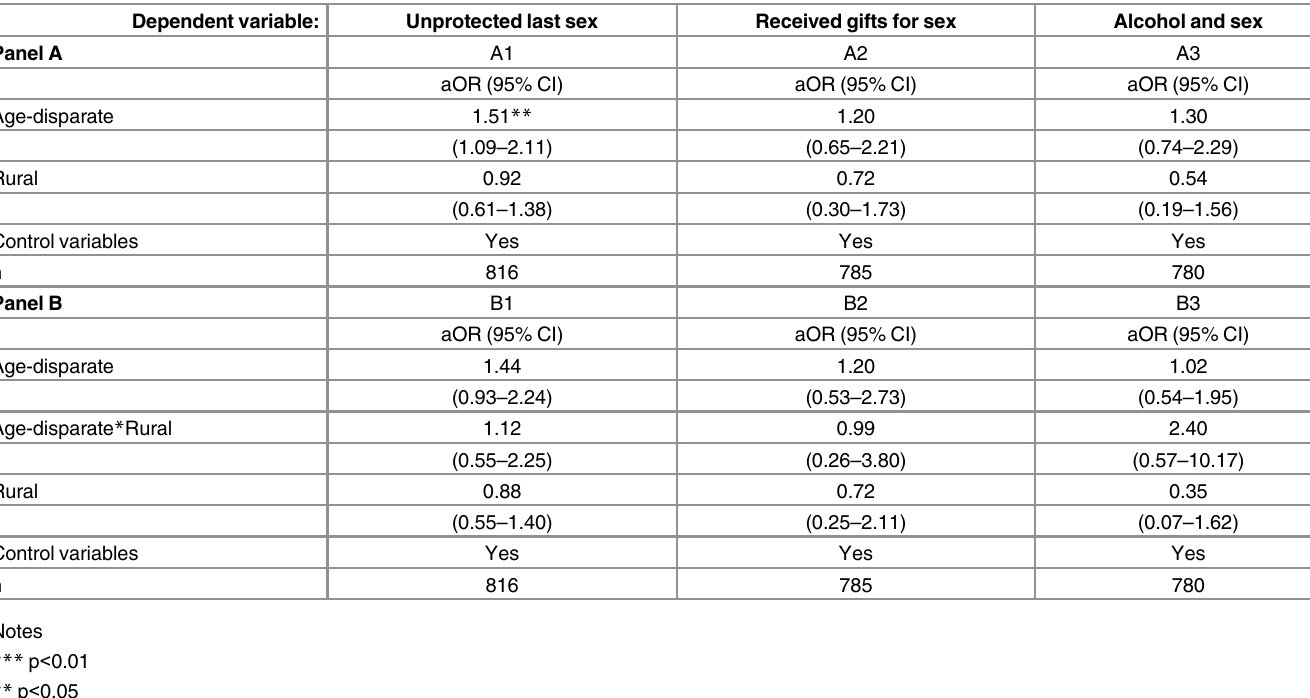
Table 2. Multiple logistic regression models of sexual behaviours within partnerships reported by 16 to 24 year old